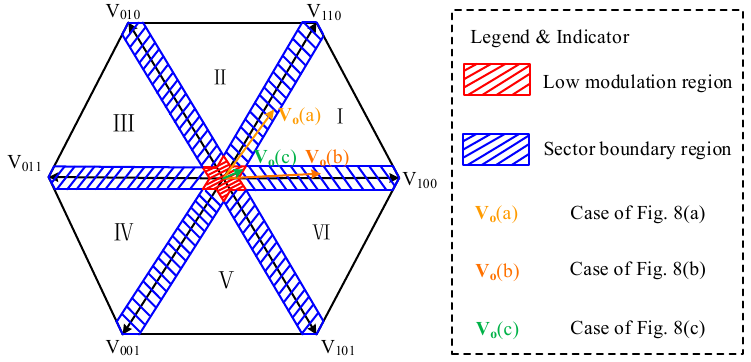
Figure 9. Current reconstruction dead zones and unmeasurable situations in Sector I.